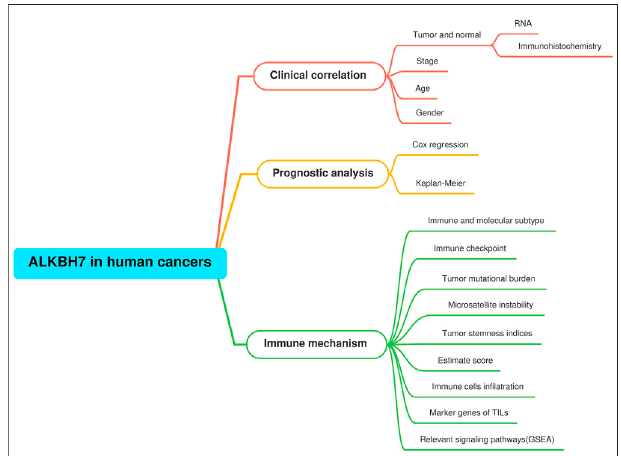
FIGURE 1 | The analysis and indicators employed in our research. In clinical correlation section, differential ALKBH7 expression analyses were performed between different tissues (tumor versus normal), ages ( ≤ 60 versus > 60), genders (male versus female), stages (stage I + II versus stage III + IV). Prognostic analysis was based on univariate Cox regression and Kaplan- Meier survival curve. In immune mechanism section, relevant signaling pathways were explored by GSEA based on the ALKBH7